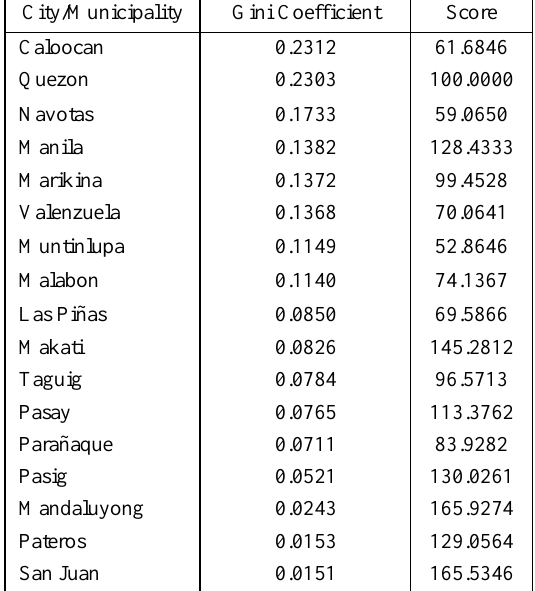
Table 3: Gini Coefficients for National Capital